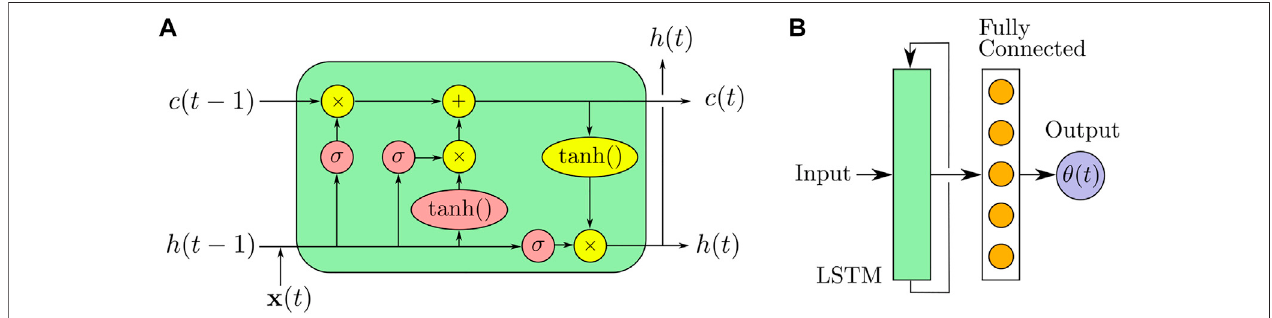
FIGURE 4 | Neural network architecture. (A) Visualization of an LSTM block as represented by Eq. 5 – 10 . (B) Our network consists of an LSTM layer connected to one fully-connected neuron layer.).